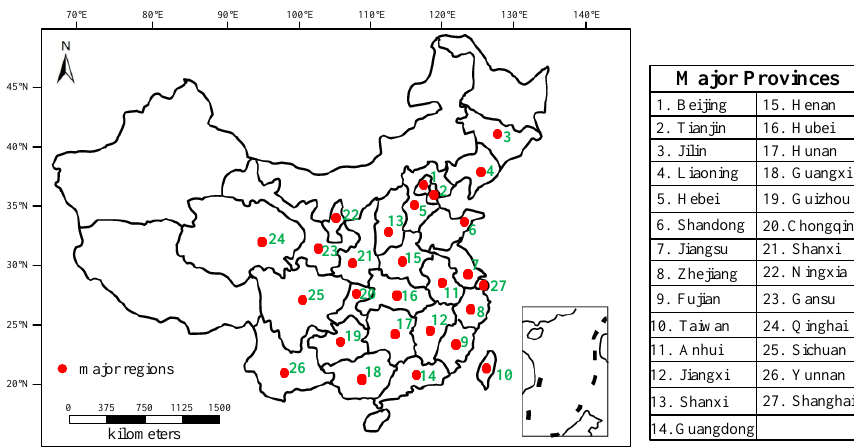
Figure 2. The major regions of the remote sensing images